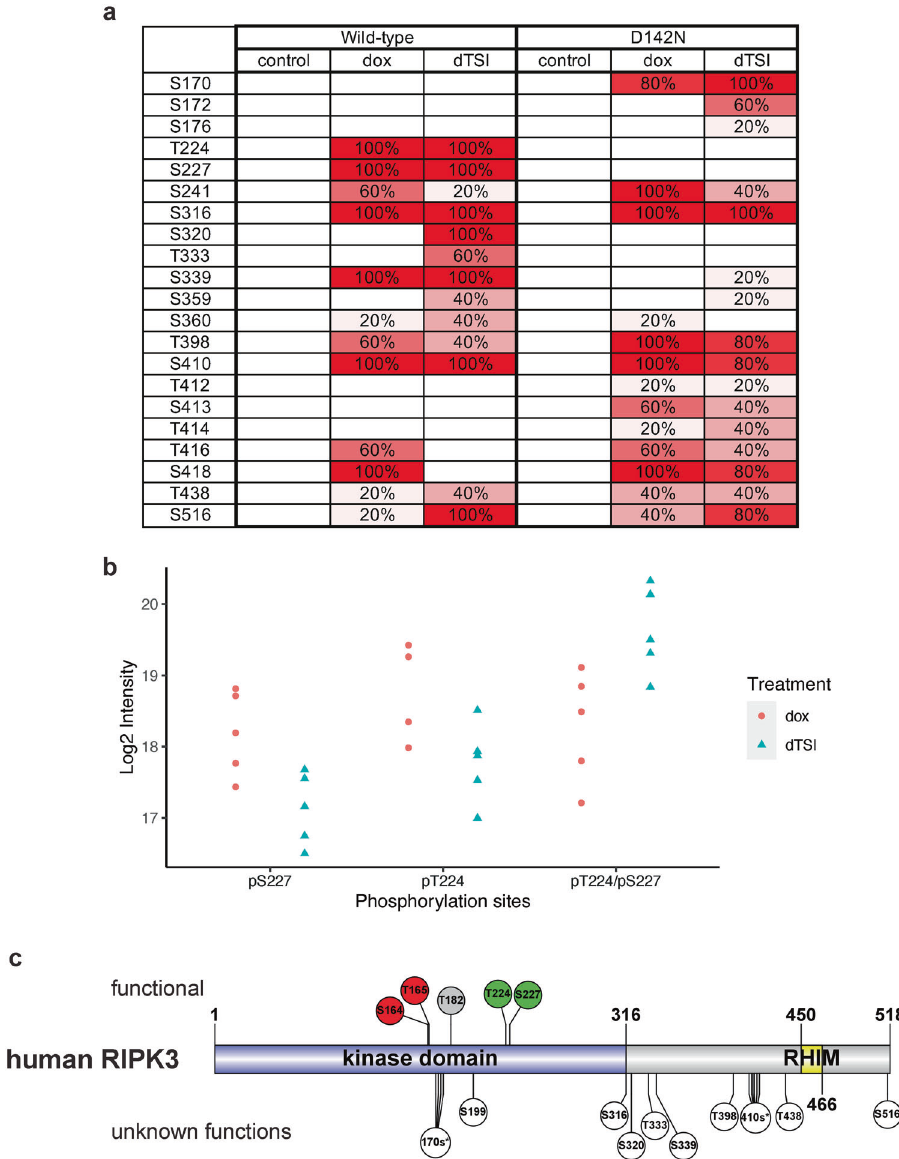
Fig. 2 Identi fi cation of human RIPK3 phosphorylation sites using mass spectrometry. a and b RIPK3 phosphorylation sites were detected in the FLAG-immunoprecipitates of HT29 RIPK3 − / − cells containing doxycycline-inducible FLAG-RIPK3 (wild-type and D142N kinase-inactive mutant). Cells were treated with doxycycline (500 ng/mL) overnight, before treatment with dTSI (d, doxycycline; T, TNF; S, Smac mimetic Compound A; I, pan-caspase inhibitor IDN-6556) for 3 h, before lysis and FLAG-immunoprecipitation. a Heatmap of the detected RIPK3 phosphorylation sites in cells with wild-type and D142N kinase-inactive mutant FLAG-RIPK3. Numbers indicate the percentage of replicates in each sample in which the phosphorylation was detected ( n = 5). Color was assigned as a gradient accordingly, where darker red color corresponds to detection of this phosphorylation in more replicates. b Scatter plot of log 2 -based peptide intensity values for the pS227 or pT224 single phosphorylation, and pT224/pS227 double phosphorylation tryptic peptide (EVELPTEPSLVYEAVCNR) in RIPK3 − / − HT29 cells with doxycycline-inducible wild-type FLAG-RIPK3, comparing cells stably expressing FLAG-RIPK3 (dox) with those stimulated to undergo necroptosis (dTSI) ( n = 5). c Schematic of human RIPK3 domain architecture and the phosphorylation sites identi fi ed. Phosphorylation sites with proposed functions are shown on the top. pT224 and pS227 positively regulates necroptosis (green) by recruiting MLKL. pS164 and pT165 negatively regulate necroptosis by inhibiting RIPK3 kinase activity (red) [38]. Although not detected in our mass spectrometry study, phosphorylation of T182 (grey) was proposed to promote RIPK3 kinase activity and to recruit PELI1 to mediate proteasomal degradation of RIPK3 [54]. Phosphorylation sites with unknown functions are shown on the bottom (white). Asterisks (*) denotes multiple serine/threonine on the same peptide, as such the exact site of phosphorylation could not be unambiguously identi fi